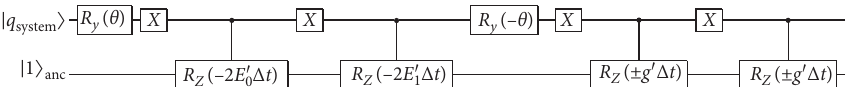
Figure 4: Implementation of one iteration of the system with decoherence algorithm. Here | q vector in the site